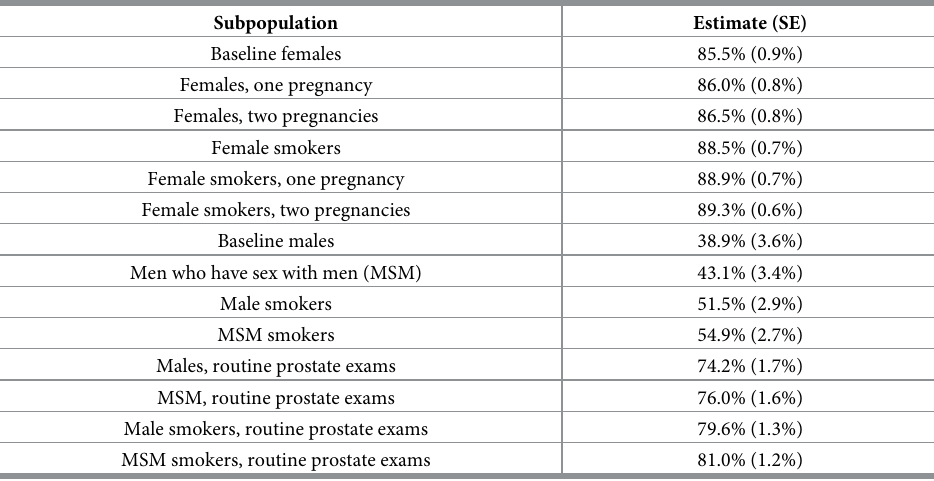
Table 3. Estimated lifetime false positive probability by